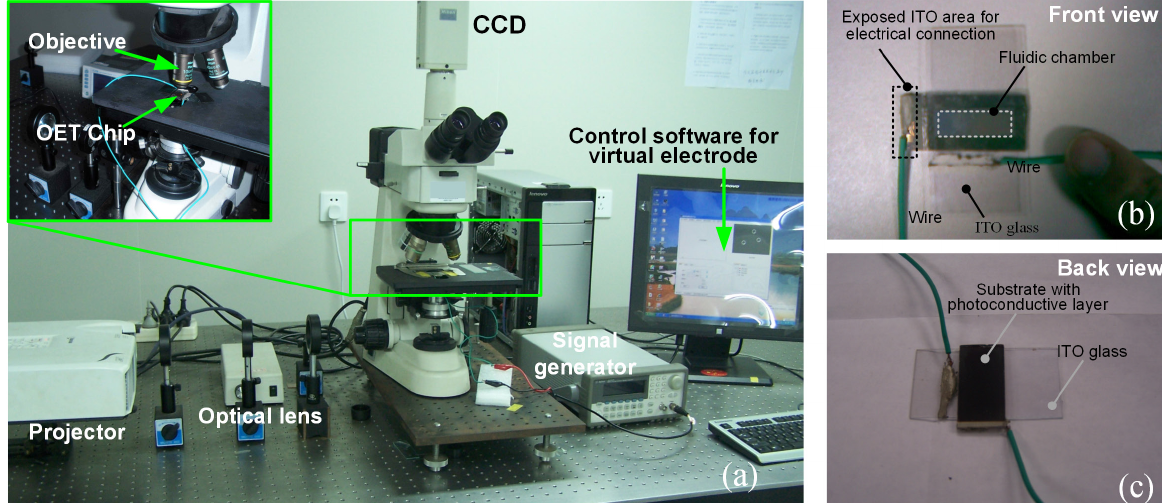
Figure 2. ( a ) Photograph of experiment setup for the real-time controllable OET platform. ( b ) Front view of the OET chip. ( c ) Back view of OET chip. CCD: charge-coupled device.